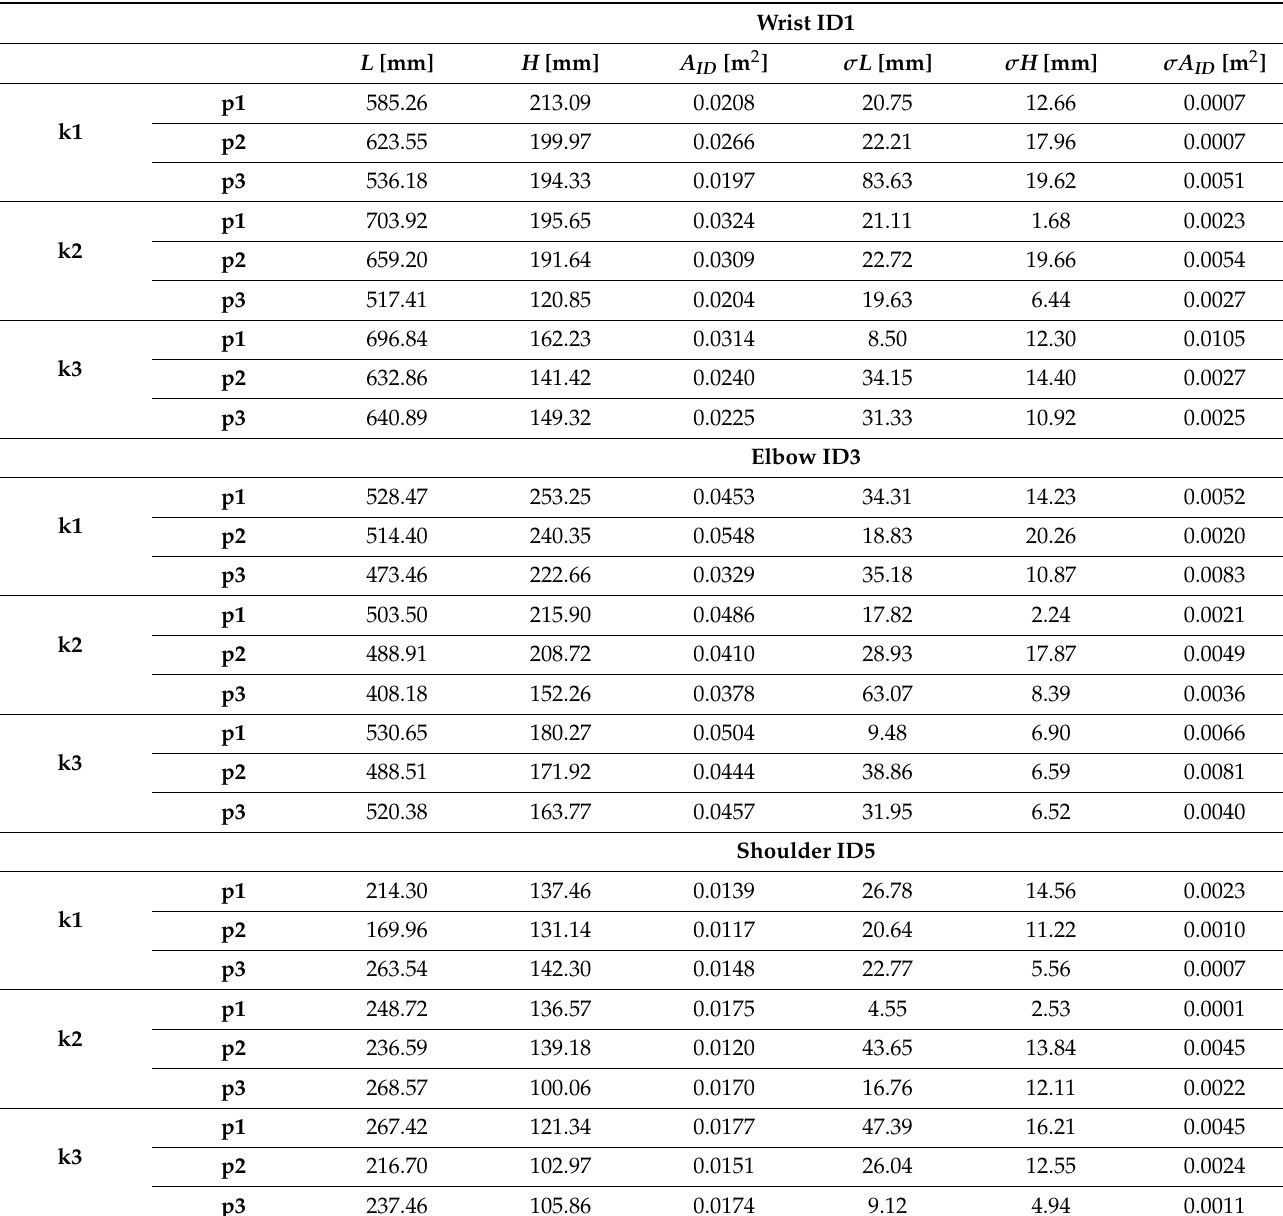
Table 6. Mean values of surface areas A ID and corresponding lengths L and widths H of the designated shapes for all of the markers; σ L —standard deviation of length, σ H —standard deviation of the height and σ A ID —standard deviation of surface